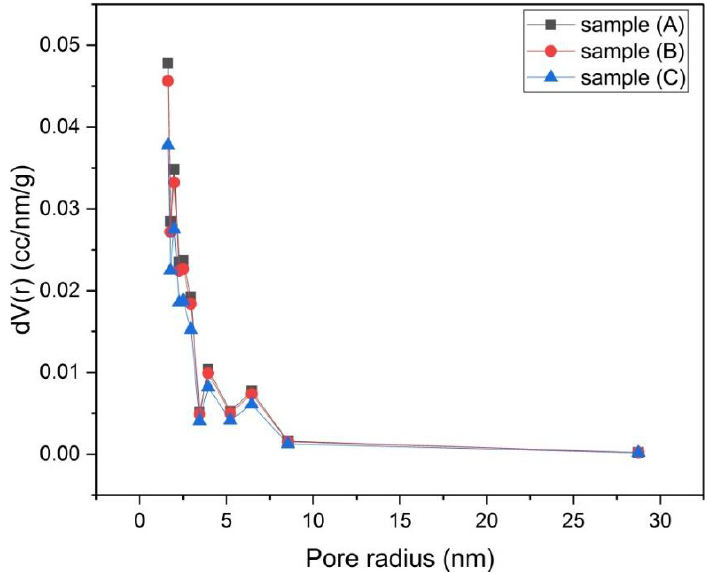
Figure 10. Mesopore size distribution by the Barrett–Joyner–Halenda (BJH) method for samples (A), (B) and